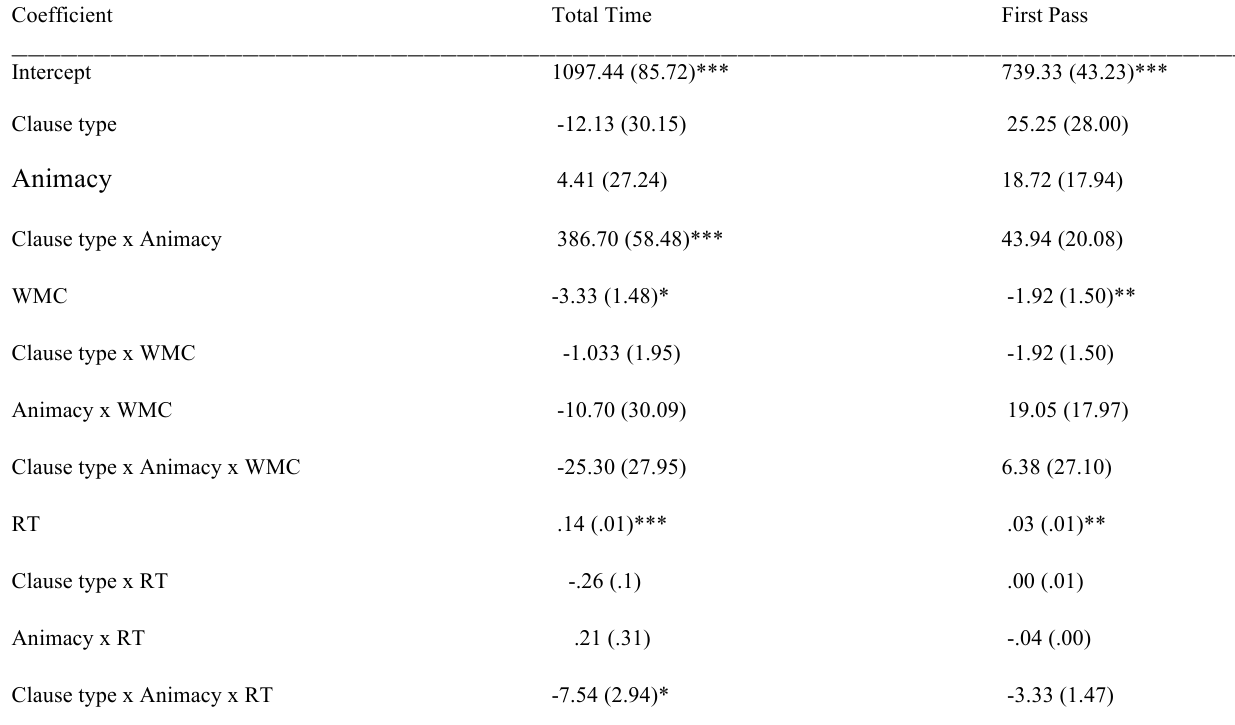
Hierarchical Linear Model – Model Estimates for Relative Clause